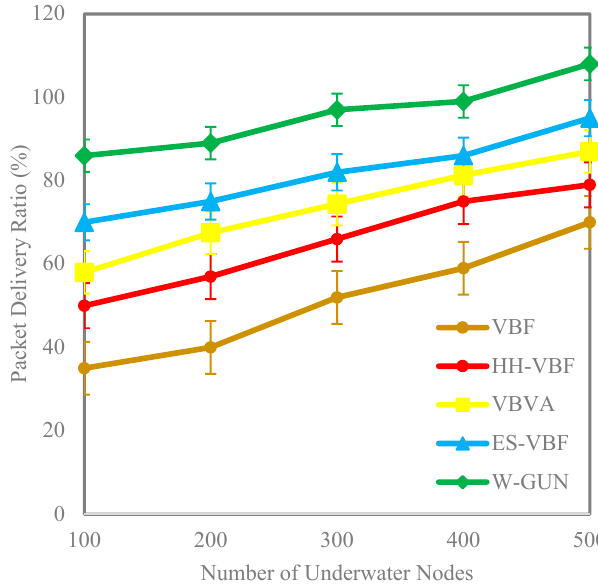
Figure 5. Packet delivery ratio versus the number of underwater nodes. Table 2. Descriptive performance observation of W-GUN in terms of packet delivery ratio.